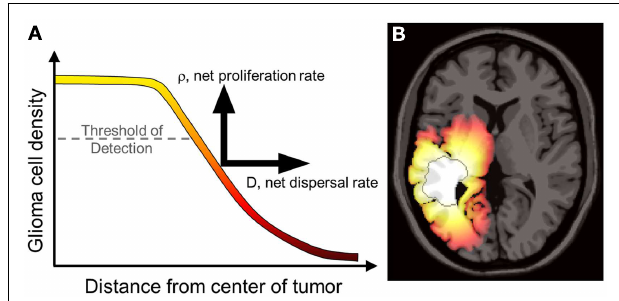
FIGURE 1 | (A) Concentrations of tumor cells contributing to a gradient of diffusely invading glioma cells extending well beyond the threshold of detection.The PI model characterizes the net rates of growth and invasion of the glioma cells contributing to this overall profile, a sum of individual cell behaviors. Swanson et al. have demonstrated that D and ρ can be calculated on a patient-specific basis and can vary widely, even for patients within the same histological grade (Harpold et al., 2007; Swanson et al., 2008a; Szeto et al., 2009b;Wang et al., 2009; Rockne et al., 2010). (B) A simulation of the reaction-diffusion mathematical model on an anatomically accurate brain phantom (Cocosco et al., 2004) with differential motility in gray and white matter as proposed by Swanson (1999).The MRI-detectable edge of the lesion is superimposed as a dark gray contour emphasizing the extent of invasion well beyond the threshold of detection. FromWang et al. (2009) with permission from Cancer